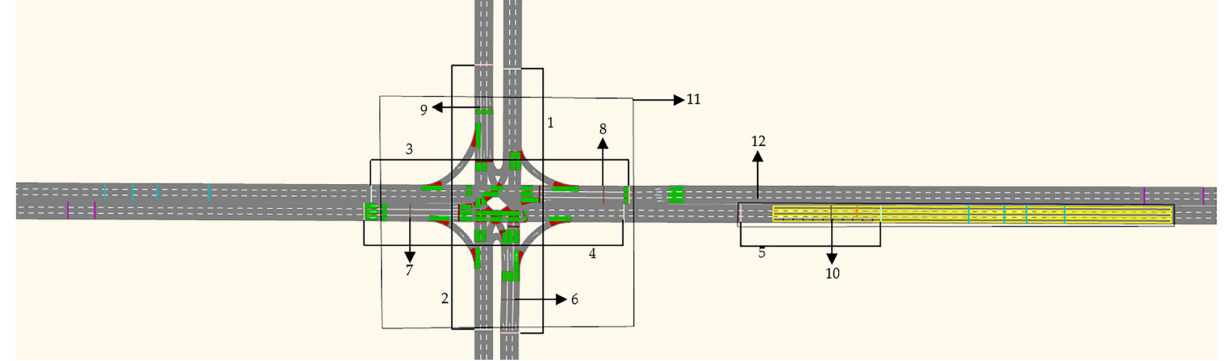
Figure 3. Detector setting.